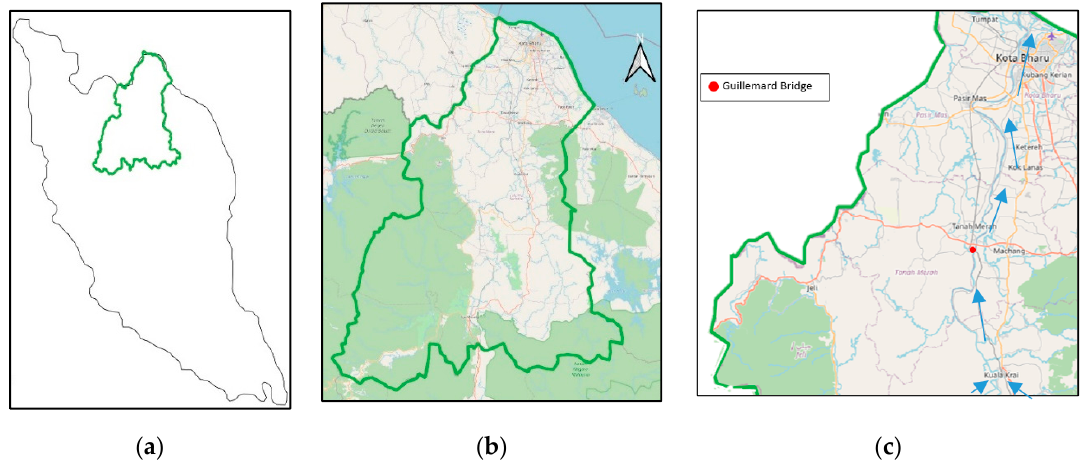
Figure 1. ( a ) Malaysia map, ( b ) Kelantan State, and ( c ) the study area (using